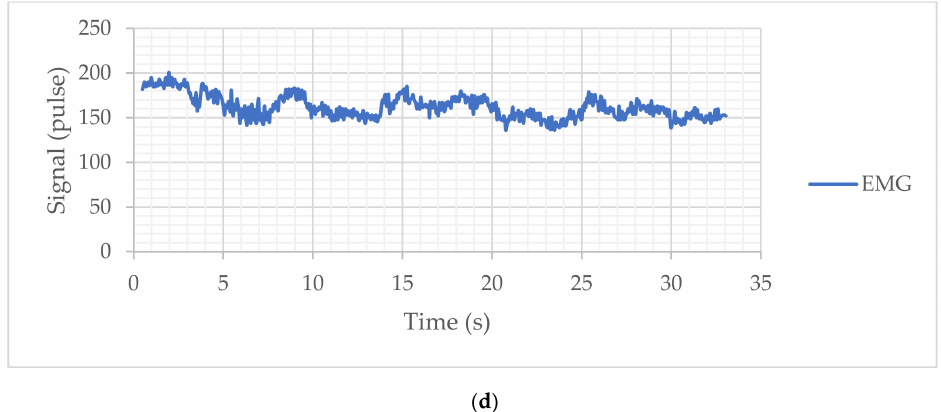
Figure 8. Results of an assisted motion with a 5 N load: ( a ) Acquired elbow articulation angle; ( b ) Acquired acceleration of wrist; ( c ) Acquired power consumption (from drawn motor current); ( d ) Acquired EMG sensor